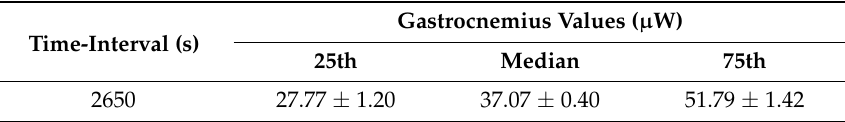
Table 4. Mean power values (n = 2). Working at desk activity.